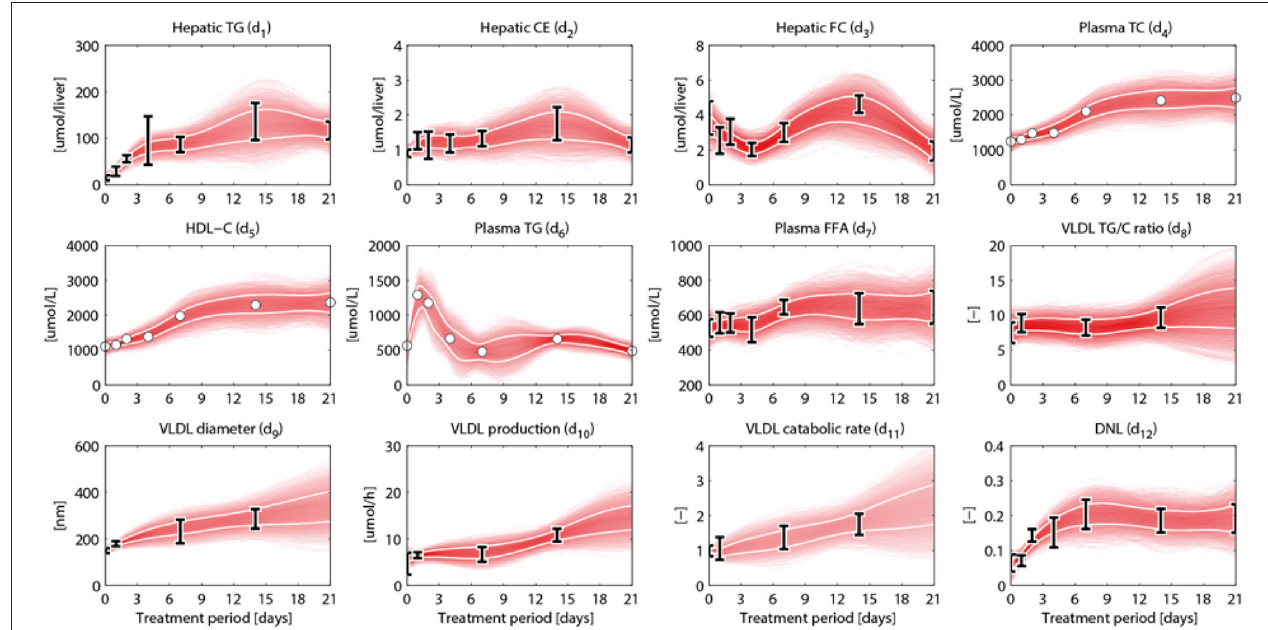
FIGURE 2 | Metabolic data and interpolants. Metabolic time-series data and 2D histograms of the splines that were used as input for ADAPT (included in χ 2 d , Equation 2). A darker color represents a higher density of trajectories in that specific region and time point. The white lines enclose the central 67% of the interpolant density at each time point. Data is represented as means ± standard deviations ( N = 5–6), with an exception for the experimental data obtained via FPLC measurements. These measurements were performed on pooled mice plasma and are represented by the white dots. Measures of variance used for the Monte Carlo sampling of these quantities were estimated based on similar experiments that were performed in Grefhorst et al.